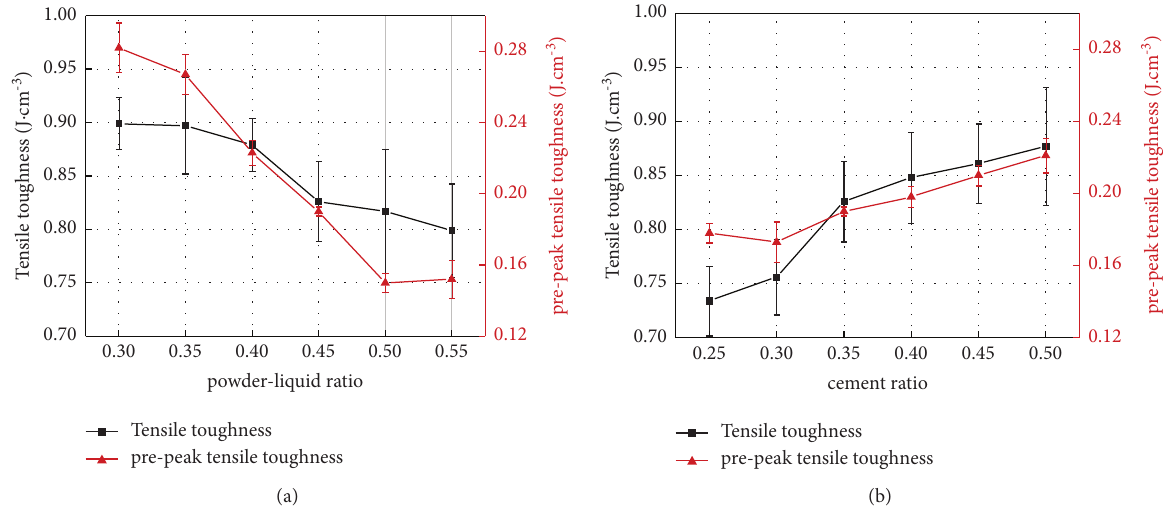
Figure 12: Changes of PCC tensile energy consumption indexes with powder-liquid ratio and cement ratio: (a) powder-liquid ratio; (b) cement